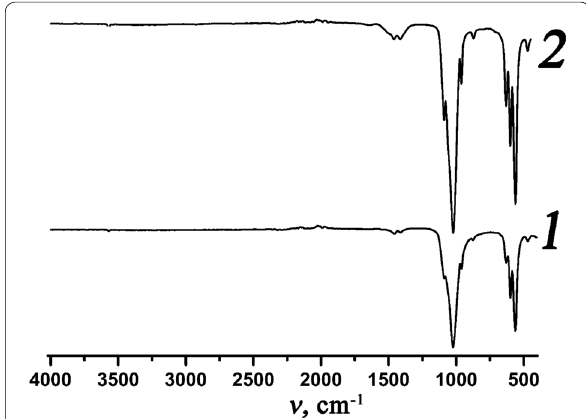
Fig. 4 FTIR-spectra for samples 6 (curve 1) and 12 (curve 2) heated to 700